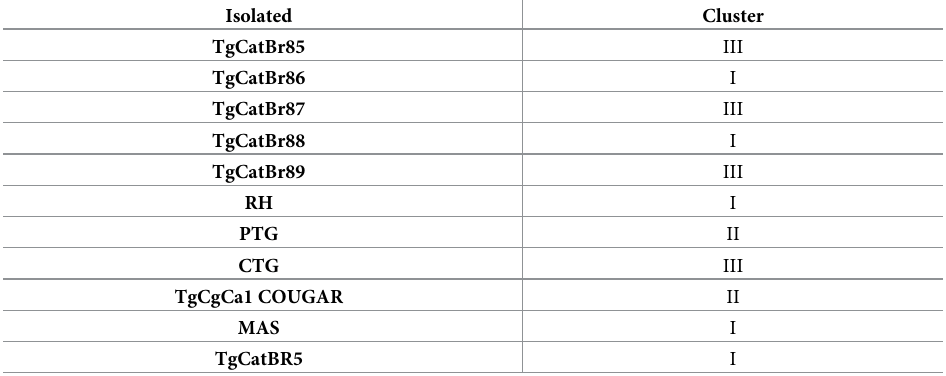
Table 2. Grouping of the genotypes found, showing similarities with the already known genotypes, using K- means cluster.